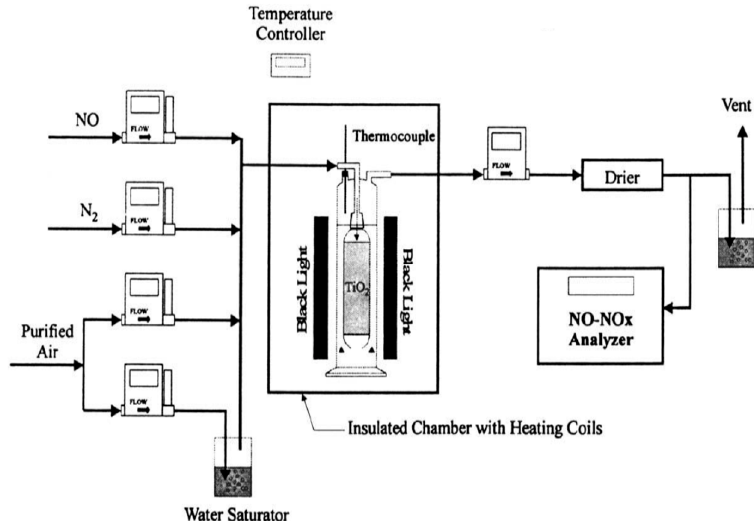
Figure 23. Experimental setup used in the disposal of NO x . The system consisted of a thin-film photoreactor coated with Degussa P-25 TiO 2 (typical loading, 1.0 mg cm 2 ) irradiated with two 8 W or 25 W black lights from both sides; light intensity of 25 W bulbs varied with a dimming electronic ballast; reactor setup and light sources were contained in insulated chamber for control of temperature; light intensity measured with UVA radiometer (range, 320–390 nm) placed inside the reactor; NO and NO 2 measured with a chemiluminescent NO–NO x gas analyzer; initial NO concentrations were 28.5 and 472 ppm; NO 2 and NO 3 − measured by chromatography. Reproduced with permission from Devahasdin and et al. [107]. Copyright 2003 by Elsevier Science B.V. (License No.: